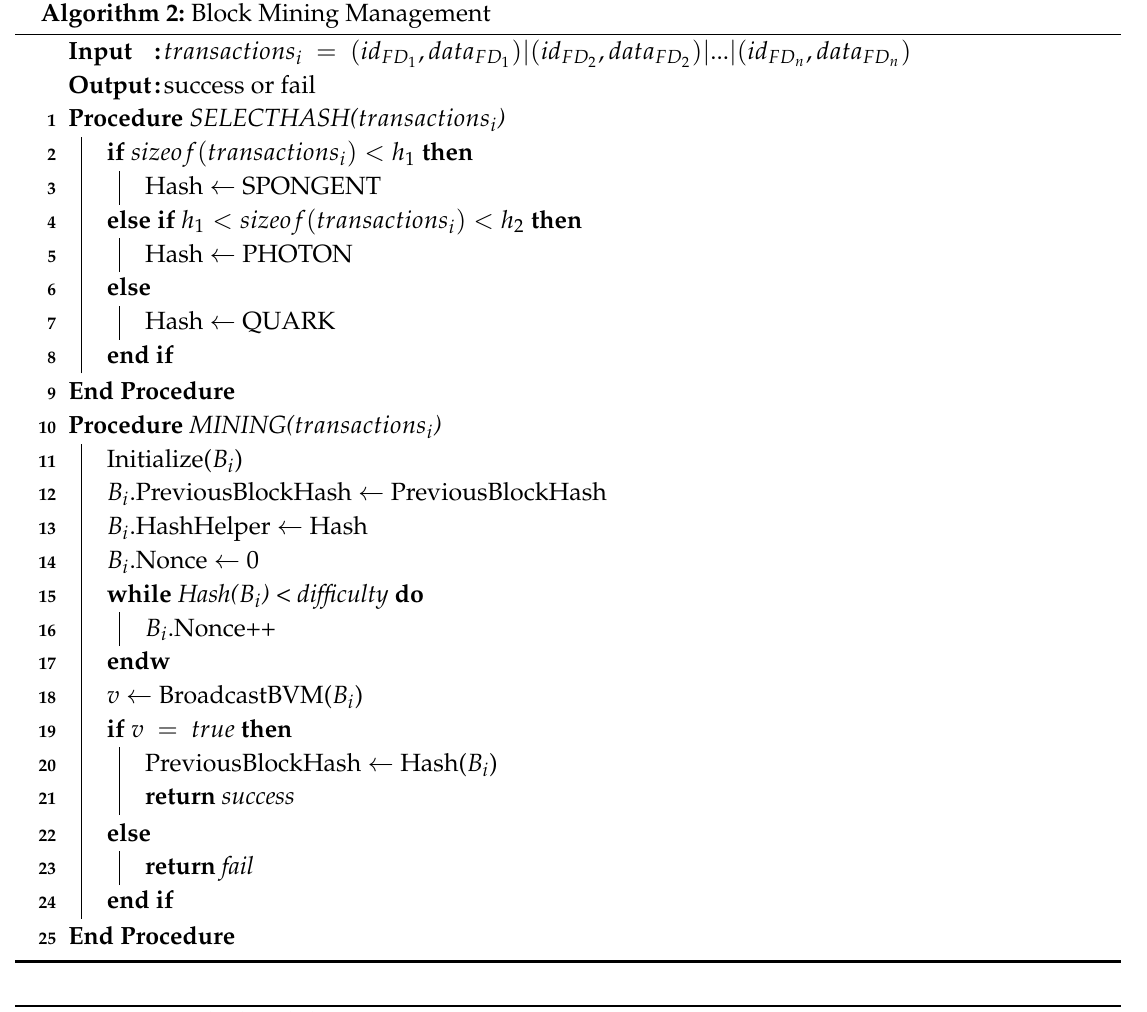
Algorithm 3: Block Validation